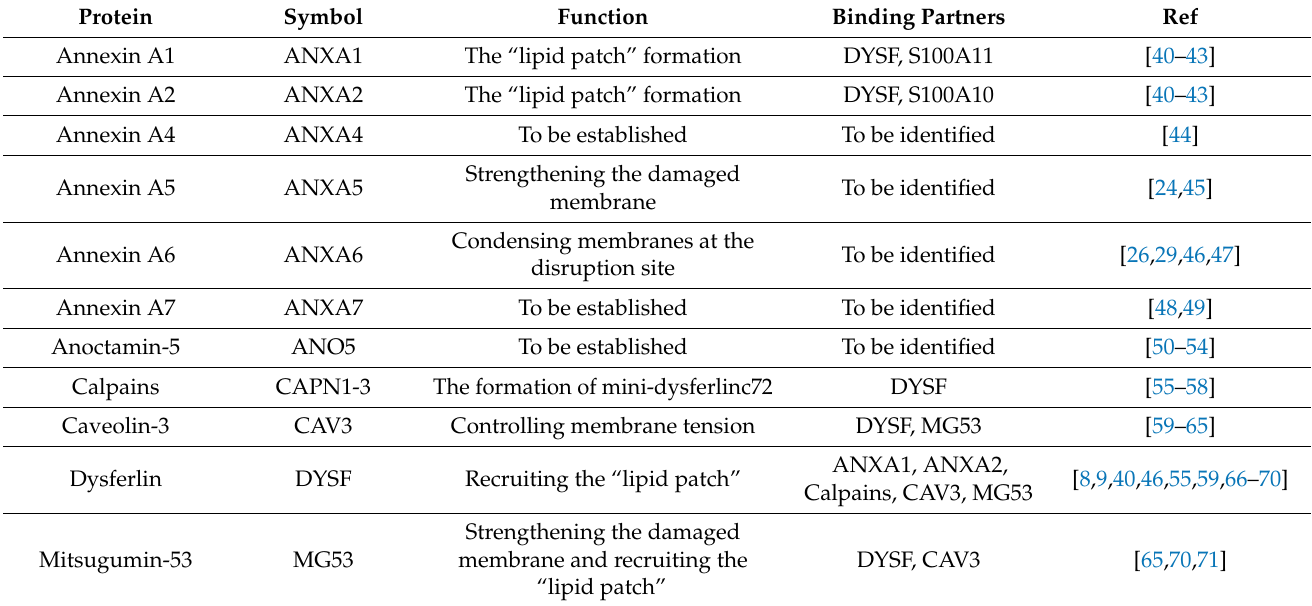
Table 1. Overview of proteins involved in sarcolemma repair.